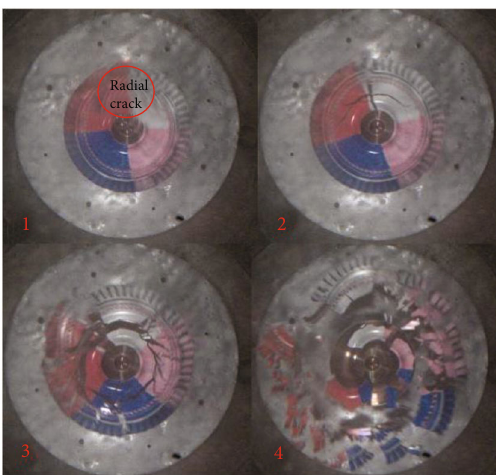
Figure 15: Rupture process of the investigated